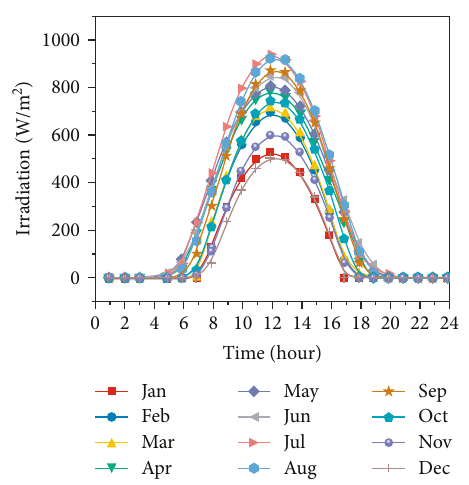
Figure 2: Average daily solar irradiation in Zaragoza for each month.